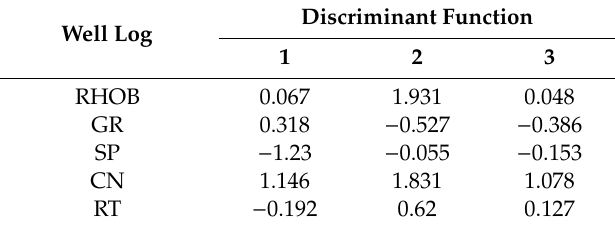
Table 5. The coe ffi cient of discriminant factors. Table 5. The coefficient of discriminant factors.